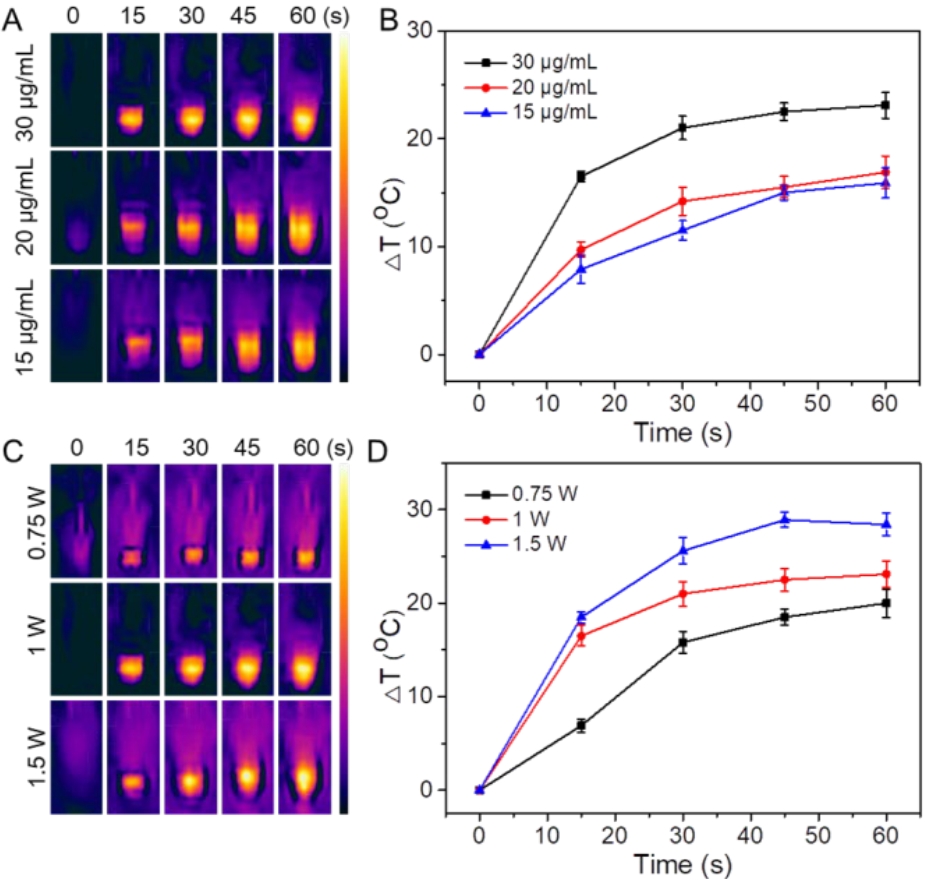
Figure 3. ( A ) Photothermal images and ( B ) the heating curve of RDP/I at different concentrations with NIR irradiation (1 W); ( C ) photothermal images and ( D ) the heating curve of RDP/I (IR780 concentration was 30 µ g/mL) with NIR irradiation at different laser